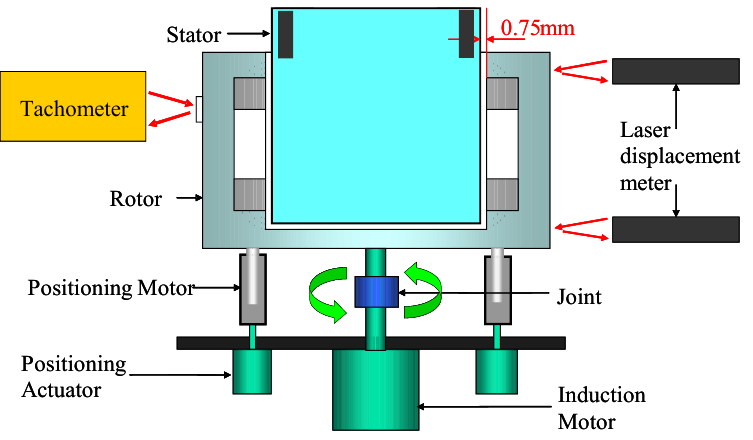
Figure 5. Experimental setup for a free-run experiment for measuring displacements at ( a ) upper position of rotor and ( b ) lower position of rotor.